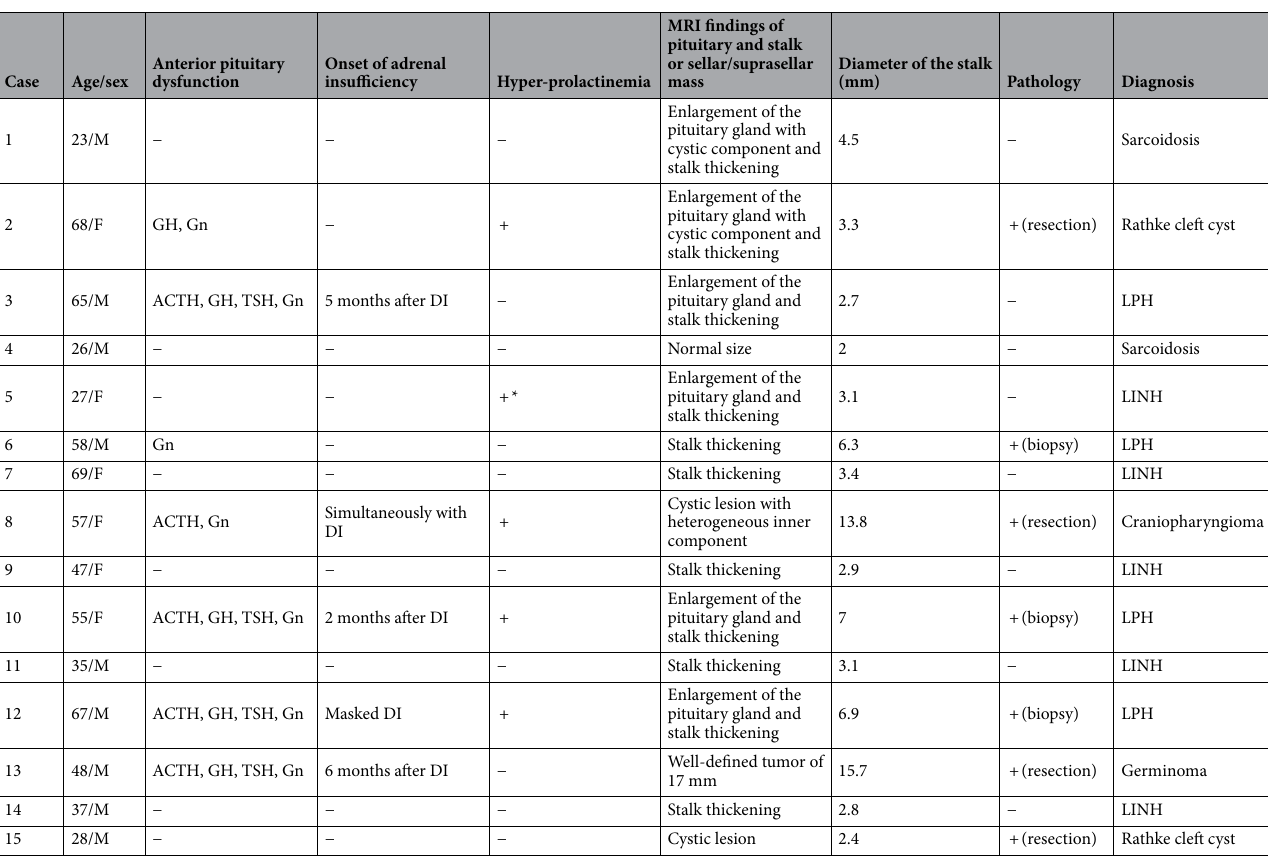
Table 1. Clinical characteristics, MRI findings of the pituitary gland, pituitary stalk or sellar mass, the stalk diameter, and diagnosis of the underlying disease in 15 patients with central diabetes insipidus. M, male;